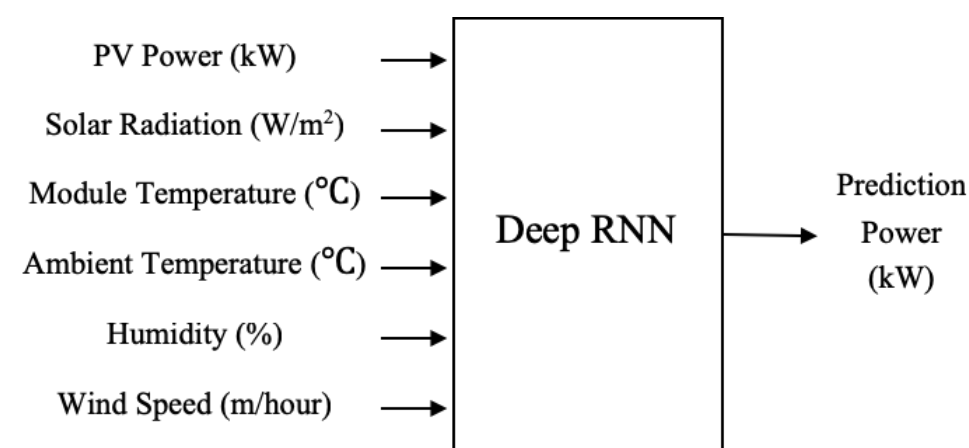
Figure 6. The PIoT sensor inputs and output of the deep RNN model to predict PV power